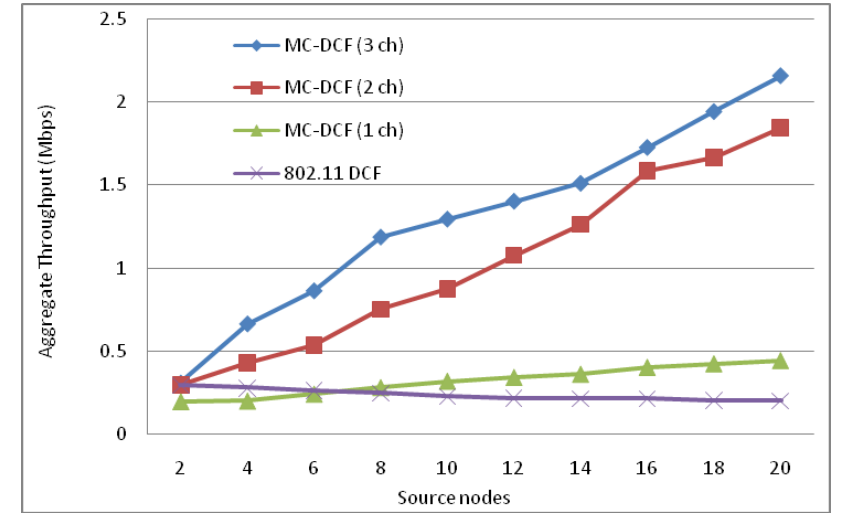
Figure 18. Throughput of overall system using multiple sink nodes with multiple radio